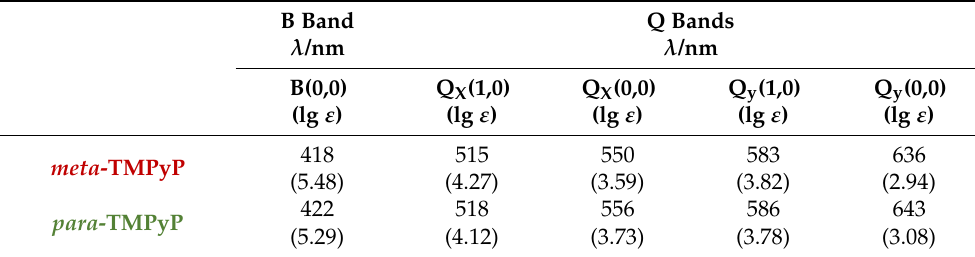
Table 1. Absorption maxima λ and molar extinction coefficient (lg ε ) of the absorption bands in the UV–VIS spectra of meta -TMPyP and para -TMPyP in aqueous